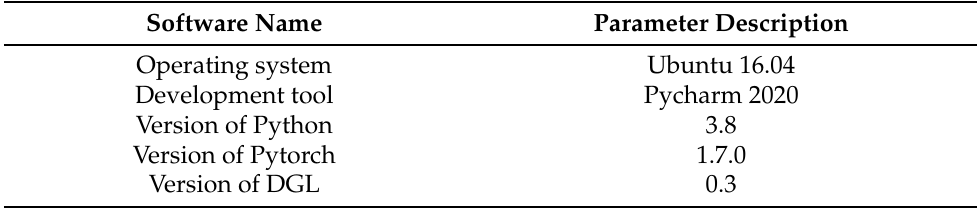
Table 3. Software